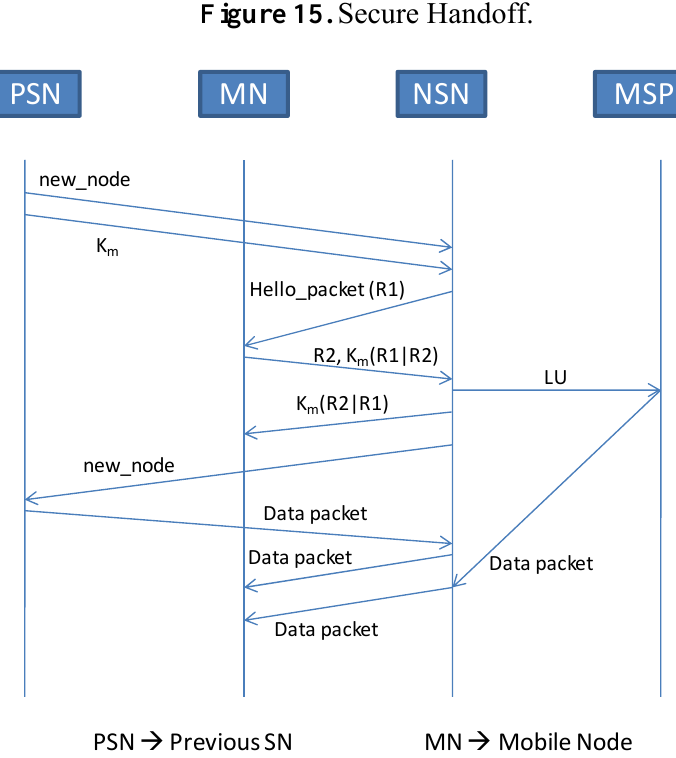
Figure 15. Secure